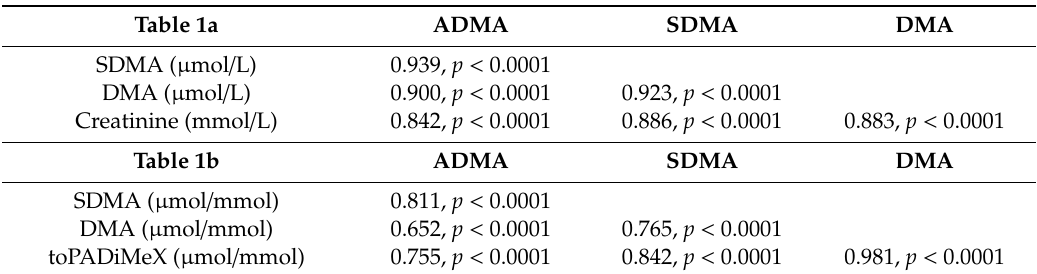
Table 1. Spearman correlation coe ffi cients between the concentrations ( a ) and creatinine-corrected excretion rates ( b ) of the analytes in the urine samples for all volunteers, meals, and time points ( n